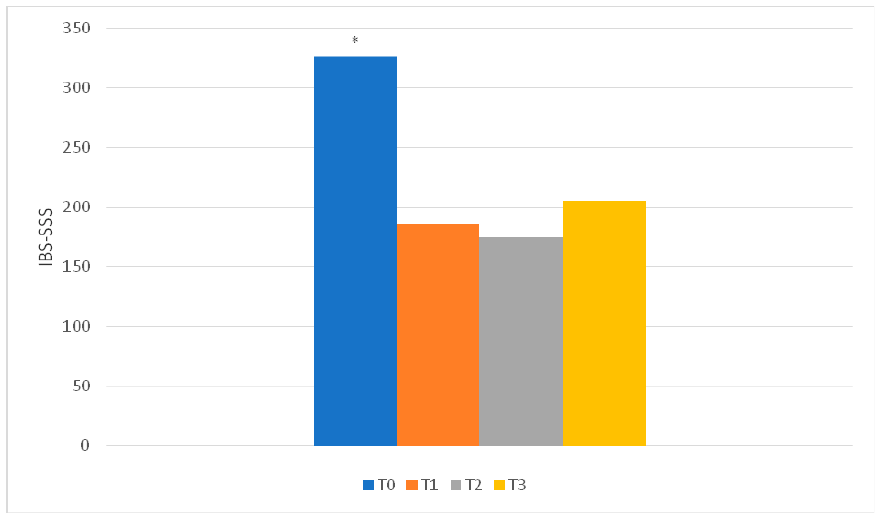
Figure 2. IBS-SSS (IBS—Symptom Severity Score) total score results. * T0 vs others: p < 0.001. No